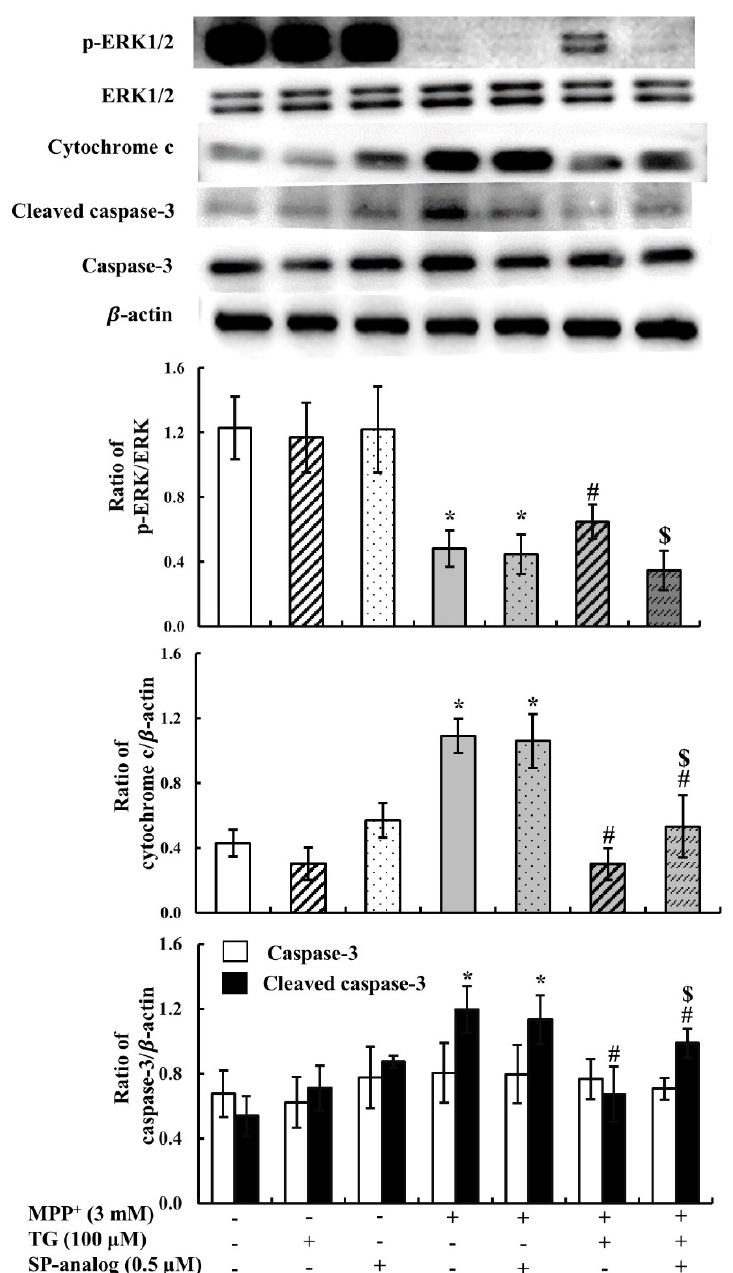
Figure 6. Teaghrelin (TG) attenuated 1-methyl-4-phenylpyridinium (MPP + )-induced neurotoxicity through activation of the extracellular signal-regulated kinase 1 and 2 (ERK1 / 2) pathway. SH-SY5Y cells were treated with TG or substance P (SP-analog) in the presence or absence of MPP + for 24 h. Cells were harvested and analyzed through Western blotting using antibodies against ERK1 / 2, p-ERK1 / 2, cytochrome c, caspase-3, and cleaved caspase-3. The expression of β -actin and was used as the internal control. Values are presented as the mean ± standard deviation (n = 4). * p < 0.05 compared with the control group, # p < 0.05 compared with MPP + alone. $ p < 0.05 compared with the MPP + + TG group. -: untreated with drugs or compounds, + : treated with drugs or compounds.